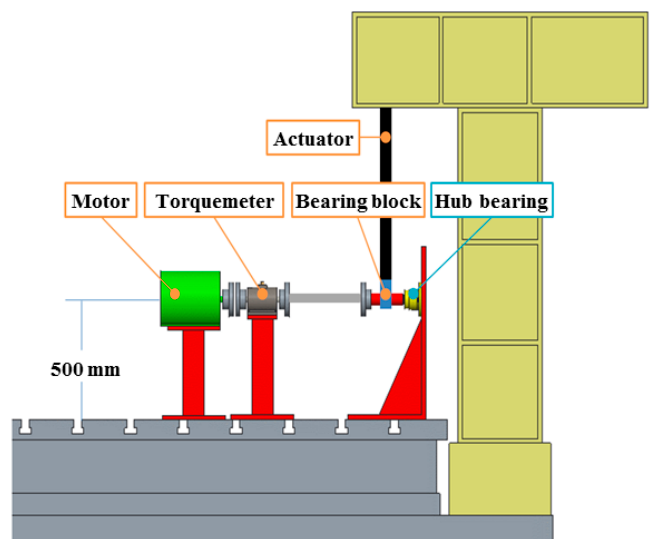
Figure 16. Schematic diagram of test rig.